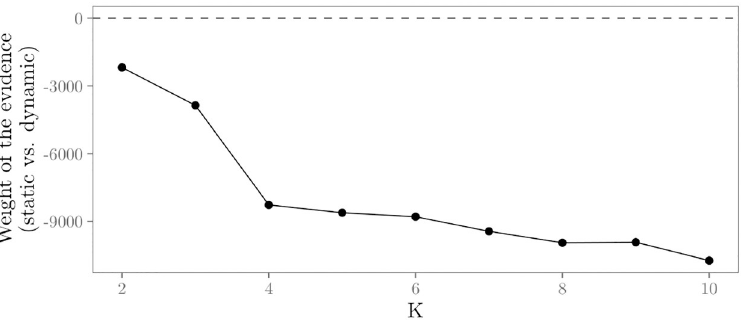
Fig 9. Results for the tests for time-varying network effects in the empirical data. Weight of the evidence (log BF) for the static vs. dynamic hypothesis with K = 2, ... , 10 for the relational event history with face-to-face contacts in the